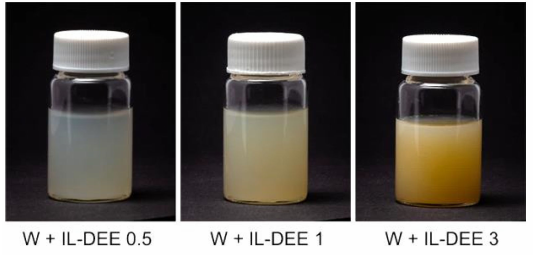
Figure 4. The appearance of investigated lubricating fluids.